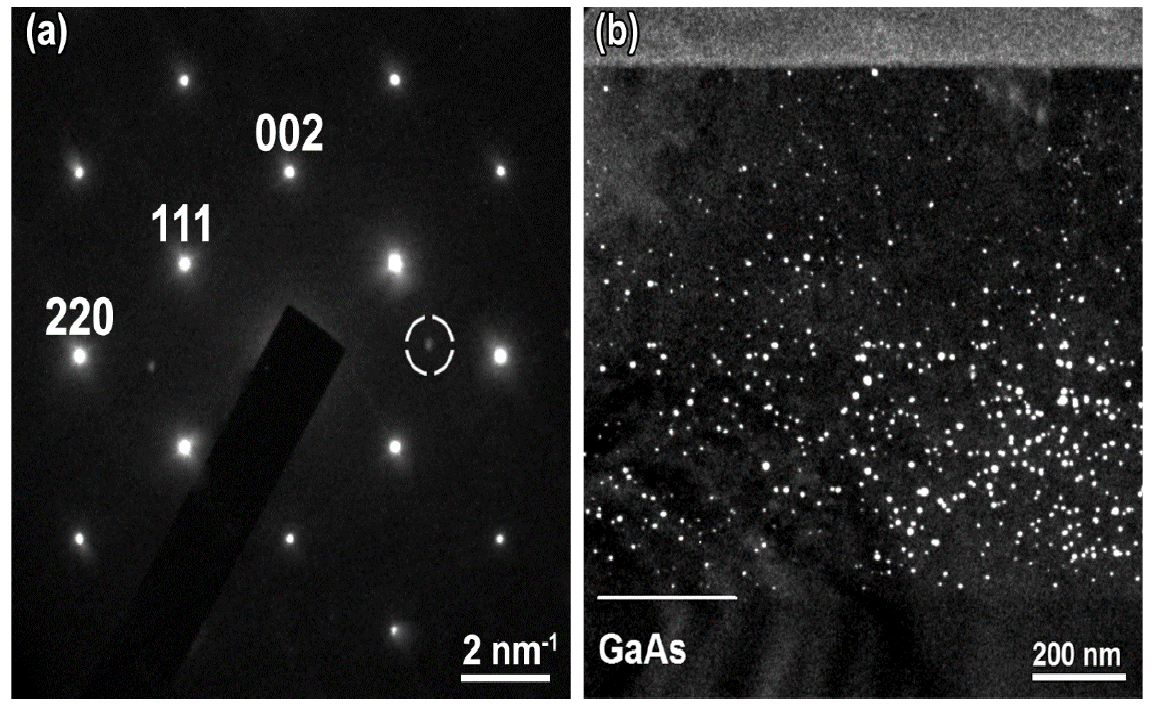
Figure 5. ( a ) Electron diffraction pattern and ( b ) micrograph acquired using the reflex of the second phase marked with dashed circle in panel ( a ). The data are for the layer of LT-Al 0.6 Ga 0.4 As 0.97 Sb 0.03 annealed at 600 °C. Table 1. Parameters of the nanoparticles in the samples annealed at 600 ◦ according to